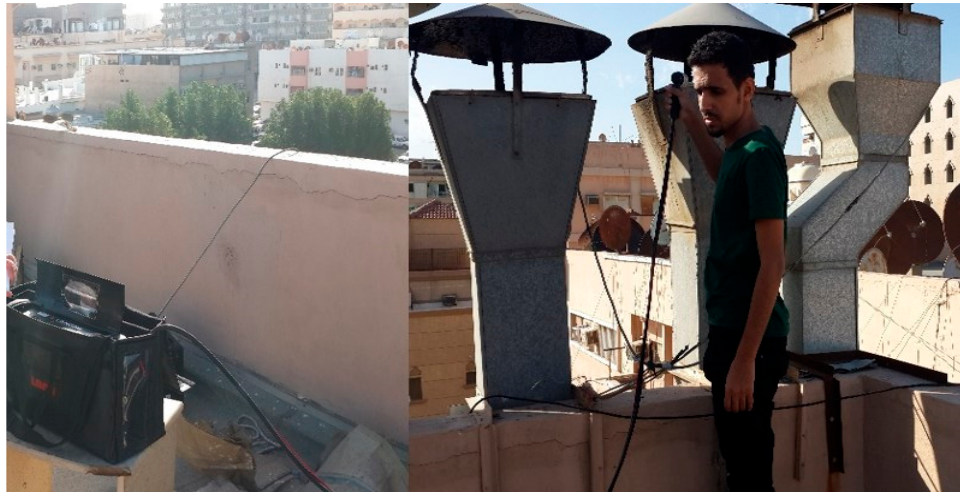
Figure 1. A real-life photograph of the sampling setup (authors personal